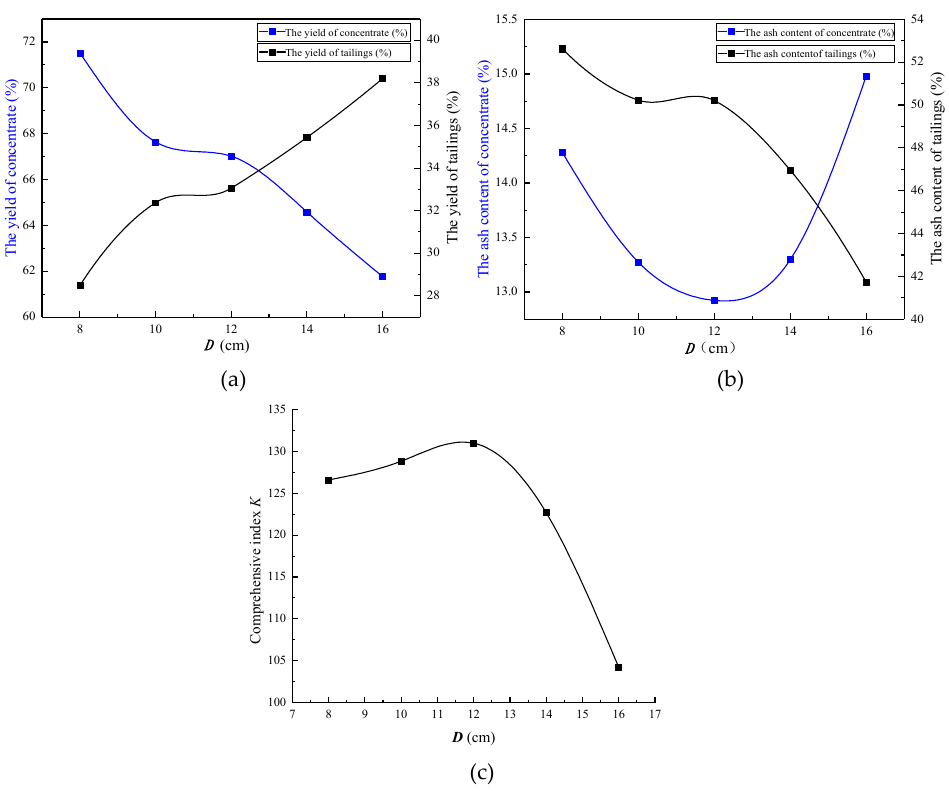
Figure 10. Effect of D on the separation effect. ( a ) Effect of the D on yield; ( b ) effect of the D on ash Figure 10. E ff ect of D on the separation e ff ect. ( a ) E ff ect of the D on yield; ( b ) e ff ect of the D on ash content; ( c ) effect of the D on K. content; ( c ) e ff ect of the D on